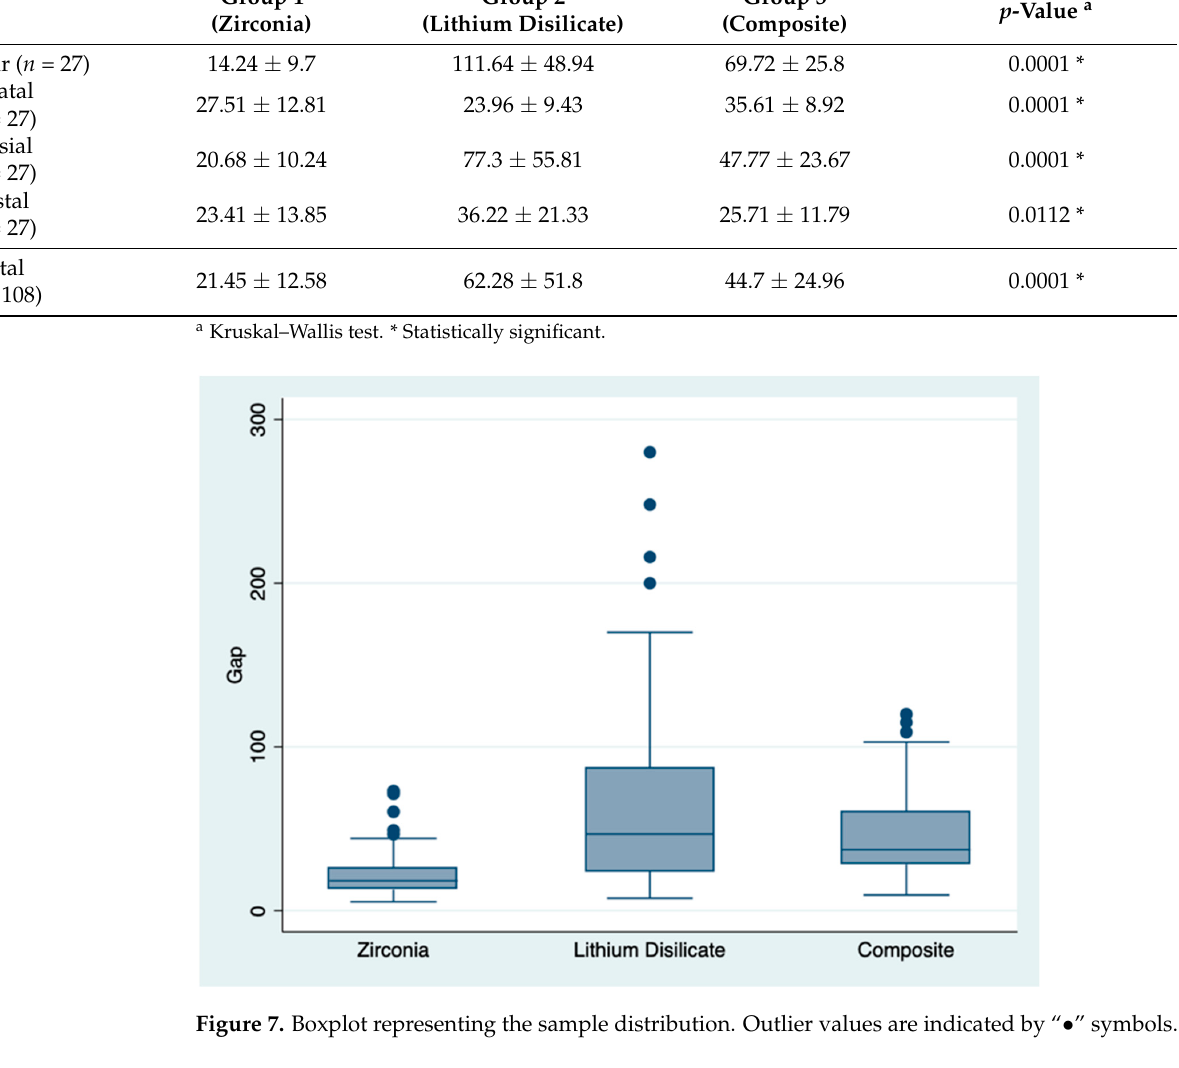
Figure 8. Boxplot representing the sample distribution according to the gap’s location: ( a ) vestibular gap; ( b ) palatal gap; ( c ) mesial gap; and ( d ) distal gap. Outlier values are indicated by “ • ” symbols.